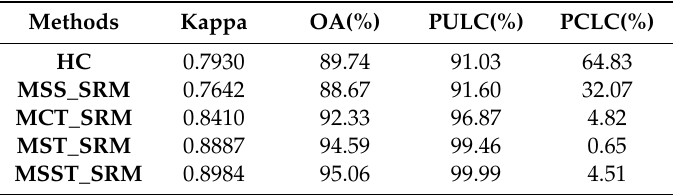
Table 2. Accuracy statistics of the di ff erent methods for Tibet Plate Lake.